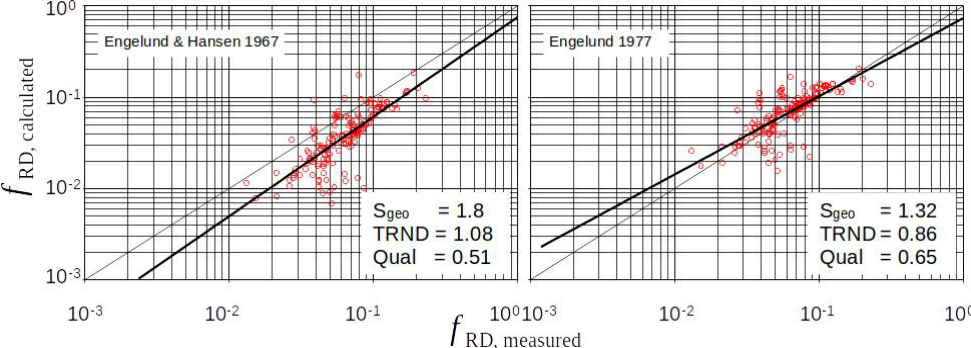
Figure 6. Approaches via energy loss at a sudden widening (Borda–Carnot) in the case of ripples.